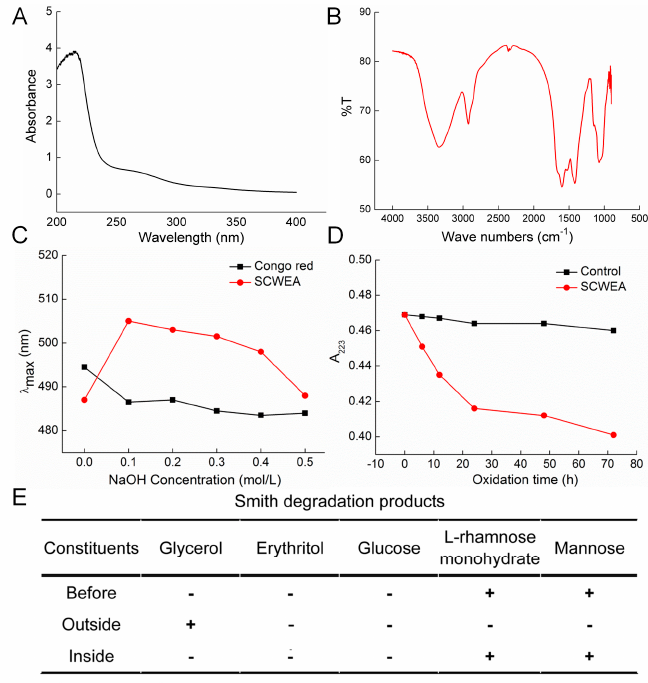
Figure 2. ( A ) Ultraviolet spectra of SCWEA; ( B ) Fourier transform infrared spectroscopy spectrum of SCWEA; ( C ) Congo red test on SCWEA; ( D ) Periodate oxidation time course; ( E ) Products of Smith degradation of SCWEA were detected using HPLC.